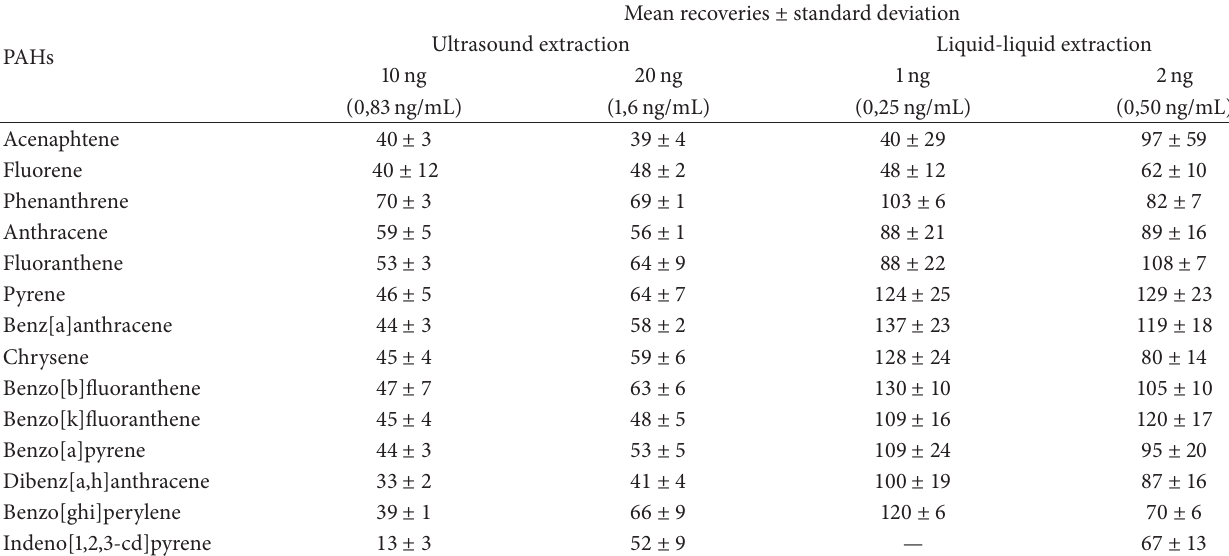
Table 2: Mean% recoveries ± standard deviation for added polycyclic aromatic hydrocarbons to black tea infusions obtained from liquid- liquid extraction with shaking after saponification step and from ultrasonication in bath